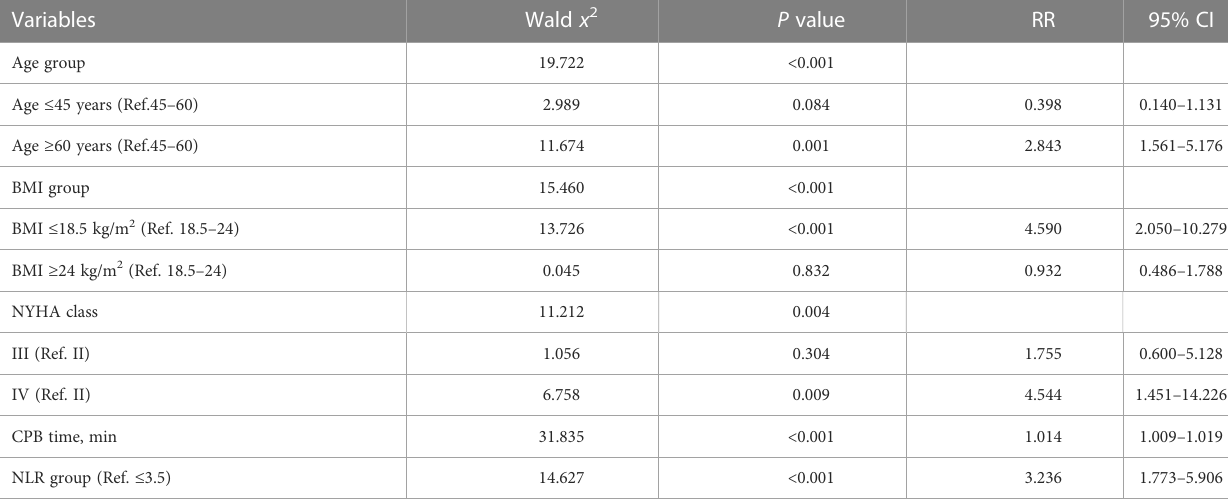
TABLE 5 Multivariable logistic regression analysis for death within 30 days after surgery.